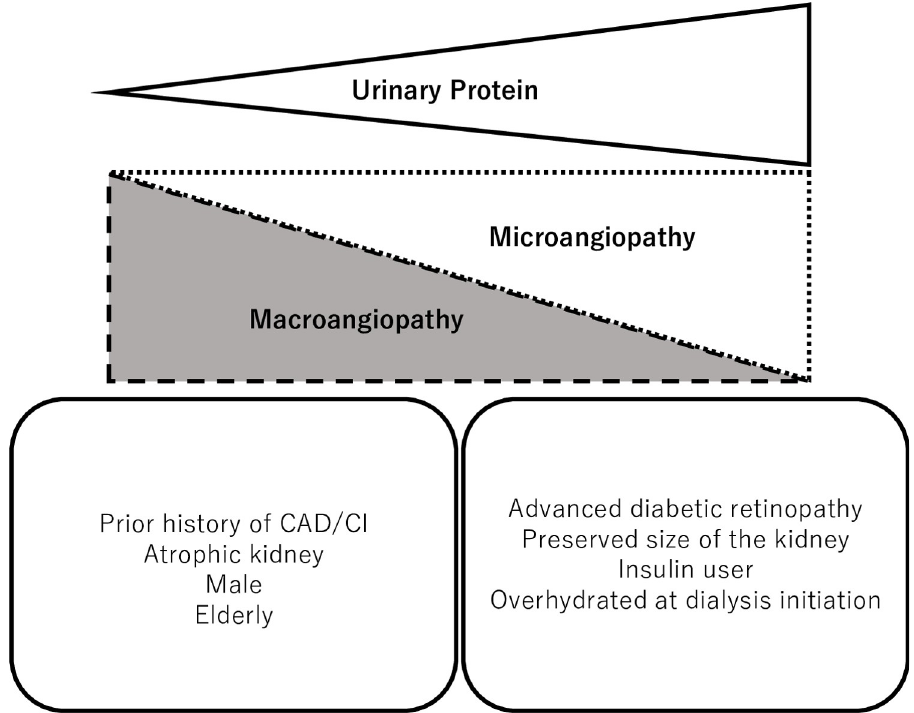
Fig 4. Heterogeneity of DKD pathogenesis and amount of proteinuria: Dominancy of macroangiopathy or microangiopathy. Patients with modest proteinuria are more likely to be male and elderly. They tend to have an atrophic kidney and a history of atherosclerotic CVD (macroangiopathy). Meanwhile, patients with massive proteinuria tend to receive insulin and suffer from overhydration. They are characterized by preserved kidney size and advanced diabetic retinopathy (microangiopathy). Abbreviations: CAD, coronary artery disease; CI, cerebral infarction; DKD, diabetic kidney disease.